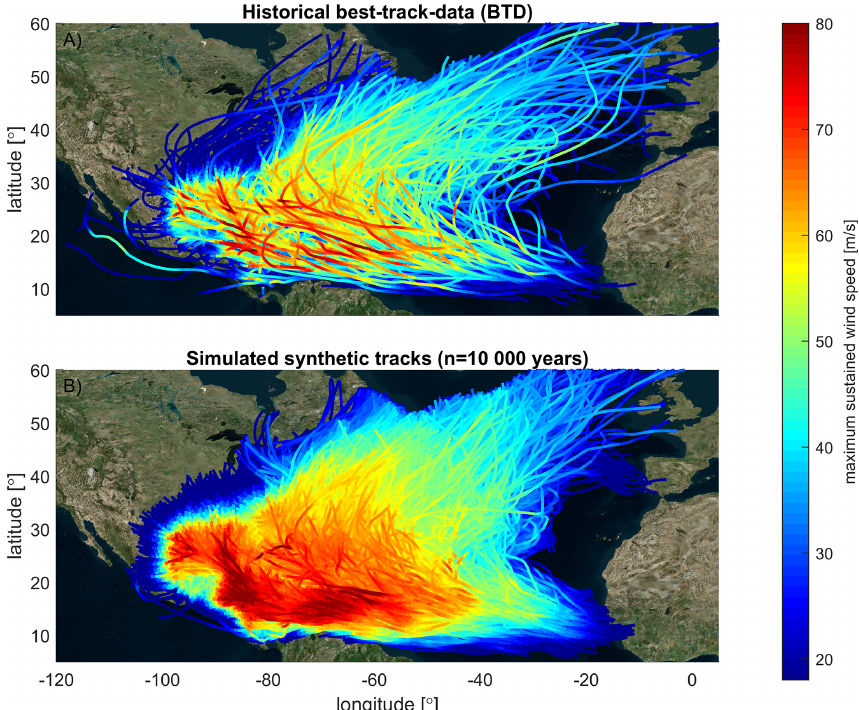
Figure 4. (a) Overview of historical tropical cyclone tracks in the IBTrACS database for the period 1886–2019. (b) 10000 years of simulated tracks with TCWiSE. Colors indicate the maximum intensity of the eye. Note that the maximum intensity is the maximum wind speed at the core of the TC, which is different from the temporally and spatially varying wind field and/or spatially varying wind swaths. In particular, further away from the TC eye, gale-force winds can still be present due to the TC. © Microsoft Bing